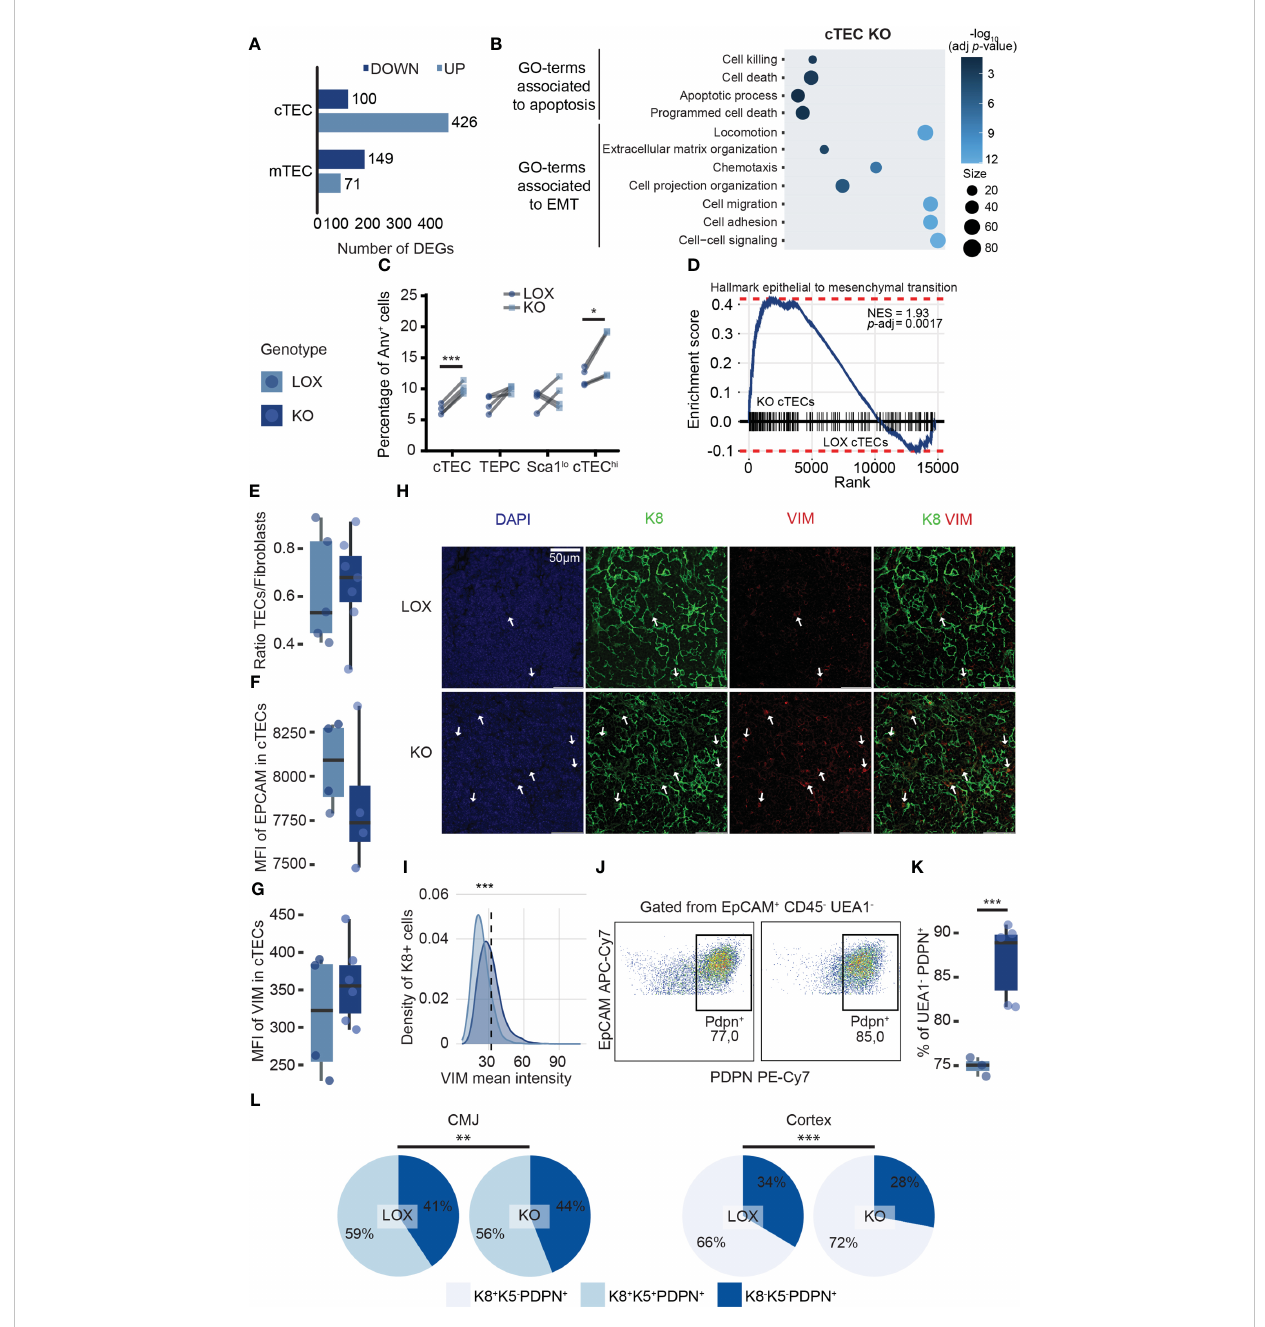
FIGURE 6 Klf4 protects cTECs during late pregnancy by inhibiting apoptosis and EMP. (A) Number of DEGs upregulated (pale blue) or downregulated (dark blue) in cTECs and mTECs from LOX pregnant females compared to KO pregnant females. DEGs were identi fi ed with a p -value< 0.05 and a fold- change > 1.5. (B) Balloon plot depicting biological processes enriched in genes differentially expressed in LOX versus KO pregnant female. Only GO terms with an adjusted p -value< 0.05 are displayed (g:SCS threshold; Analysis performed with g:Pro fi ler). (C) Paired plot showing the percentage of apoptotic cells in LOX and KO pregnant females. Signi fi cance was assessed using a paired Student ’ s t -test. (* p <0.05, *** p <0.001). (D) Gene Set Enrichment Analysis (GSEA) for epithelial to mesenchymal transition markers in cTEC from KO versus LOX pregnant females. NES, normalized enrichment score; p -adj, false discovery rate adjusted p -value. (E) Ratio TEC to fi broblasts in LOX and KO pregnant females. (F, G) Mean fl uorescence intensity (MFI) of EpCAM (F) and VIM (G) in cTECs from LOX and KO pregnant females. (H) VIM immunodetection on cortex from LOX and KO pregnant thymus. The sections were stained with anti-K8 (green) and anti-VIM (red) antibodies. Nuclei were stained with DAPI (blue). Images are representative of two mice. A z-stack of ten 40X images of 0.346 m m was turned into a single 2D image. Scale bar, 50 m m. (I) Density plot depicting the distribution of VIM mean cytometric intensity in K8+ cTECs from LOX and KO pregnant females. The dotted line represents the threshold for VIM intensity to classify VIM-negative and VIM-positive cells. Signi fi cance was assessed using a Pearson chi-square test (*** p <0.001). (J) Dot plots from fl ow cytometry analysis representing PDPN + gate within EpCAM + CD45 - UEA1 - cells in LOX (left) and KO (right) females. (K) Percentage of UEA1 - PDPN + cells in LOX and KO pregnant females. LOX and KO genotypes are displayed in pale blue and dark blue, respectively. (L) Pie charts representing TEC subpopulation proportions according to K8, K5, and PDPN expression in the CMJ and the cortex region of LOX and KO pregnant females. Signi fi cance was assessed using a Pearson chi-square test (** p <0.01, *** p